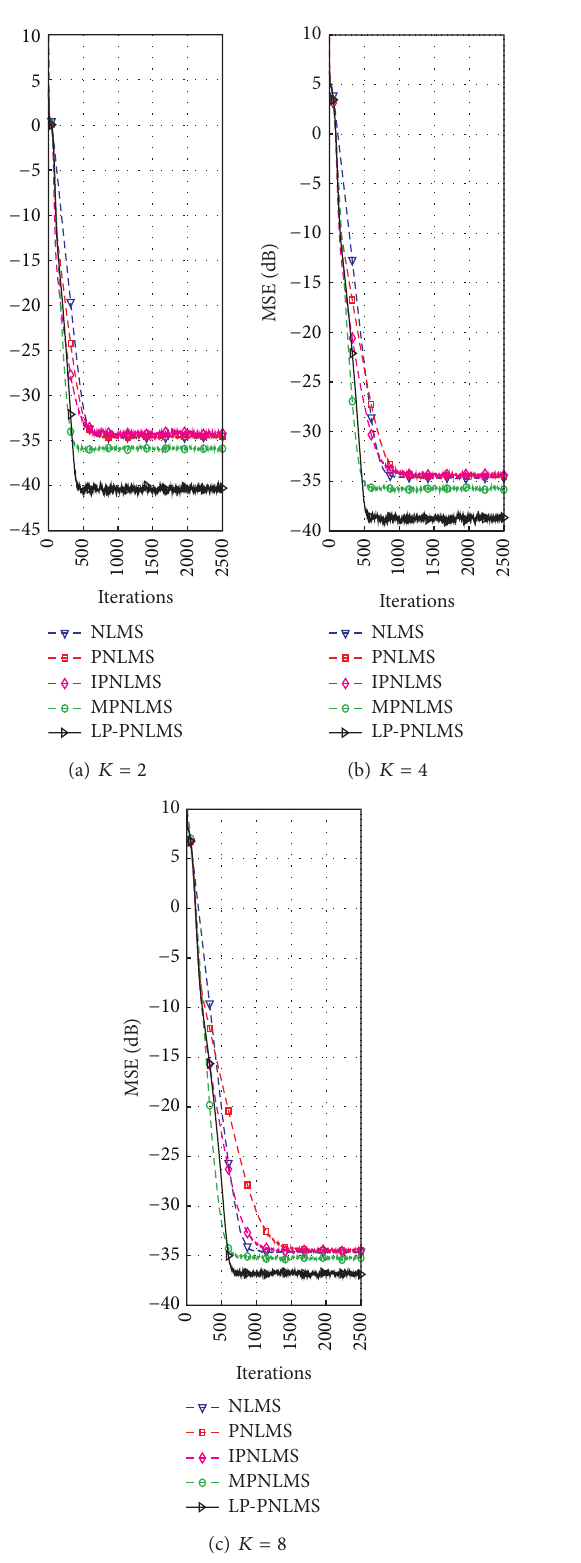
Figure 6: Effects of sparsity on the proposed LP-PNLMS algorithm for 𝑁 = 128